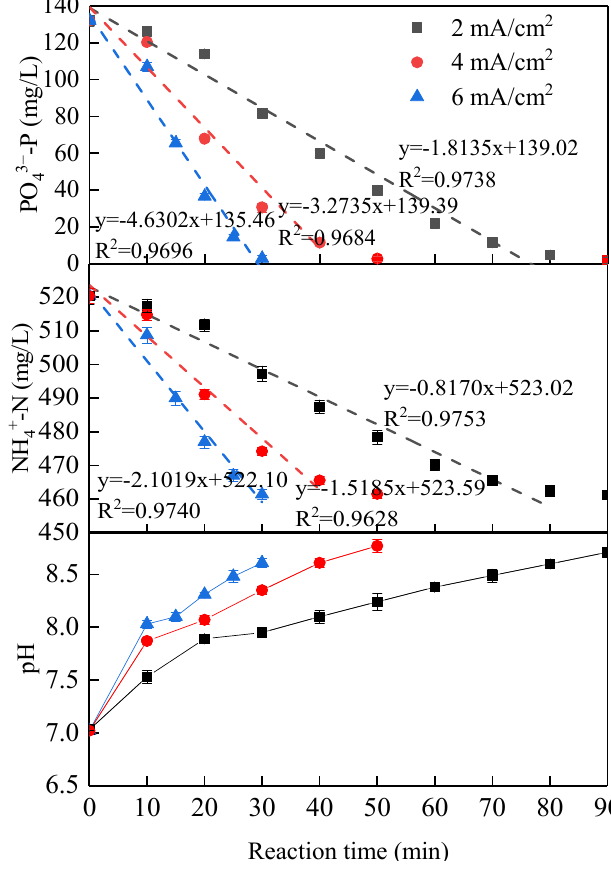
Figure 3. Effect of the current density on nutrients removal (initial pH of 7.0).